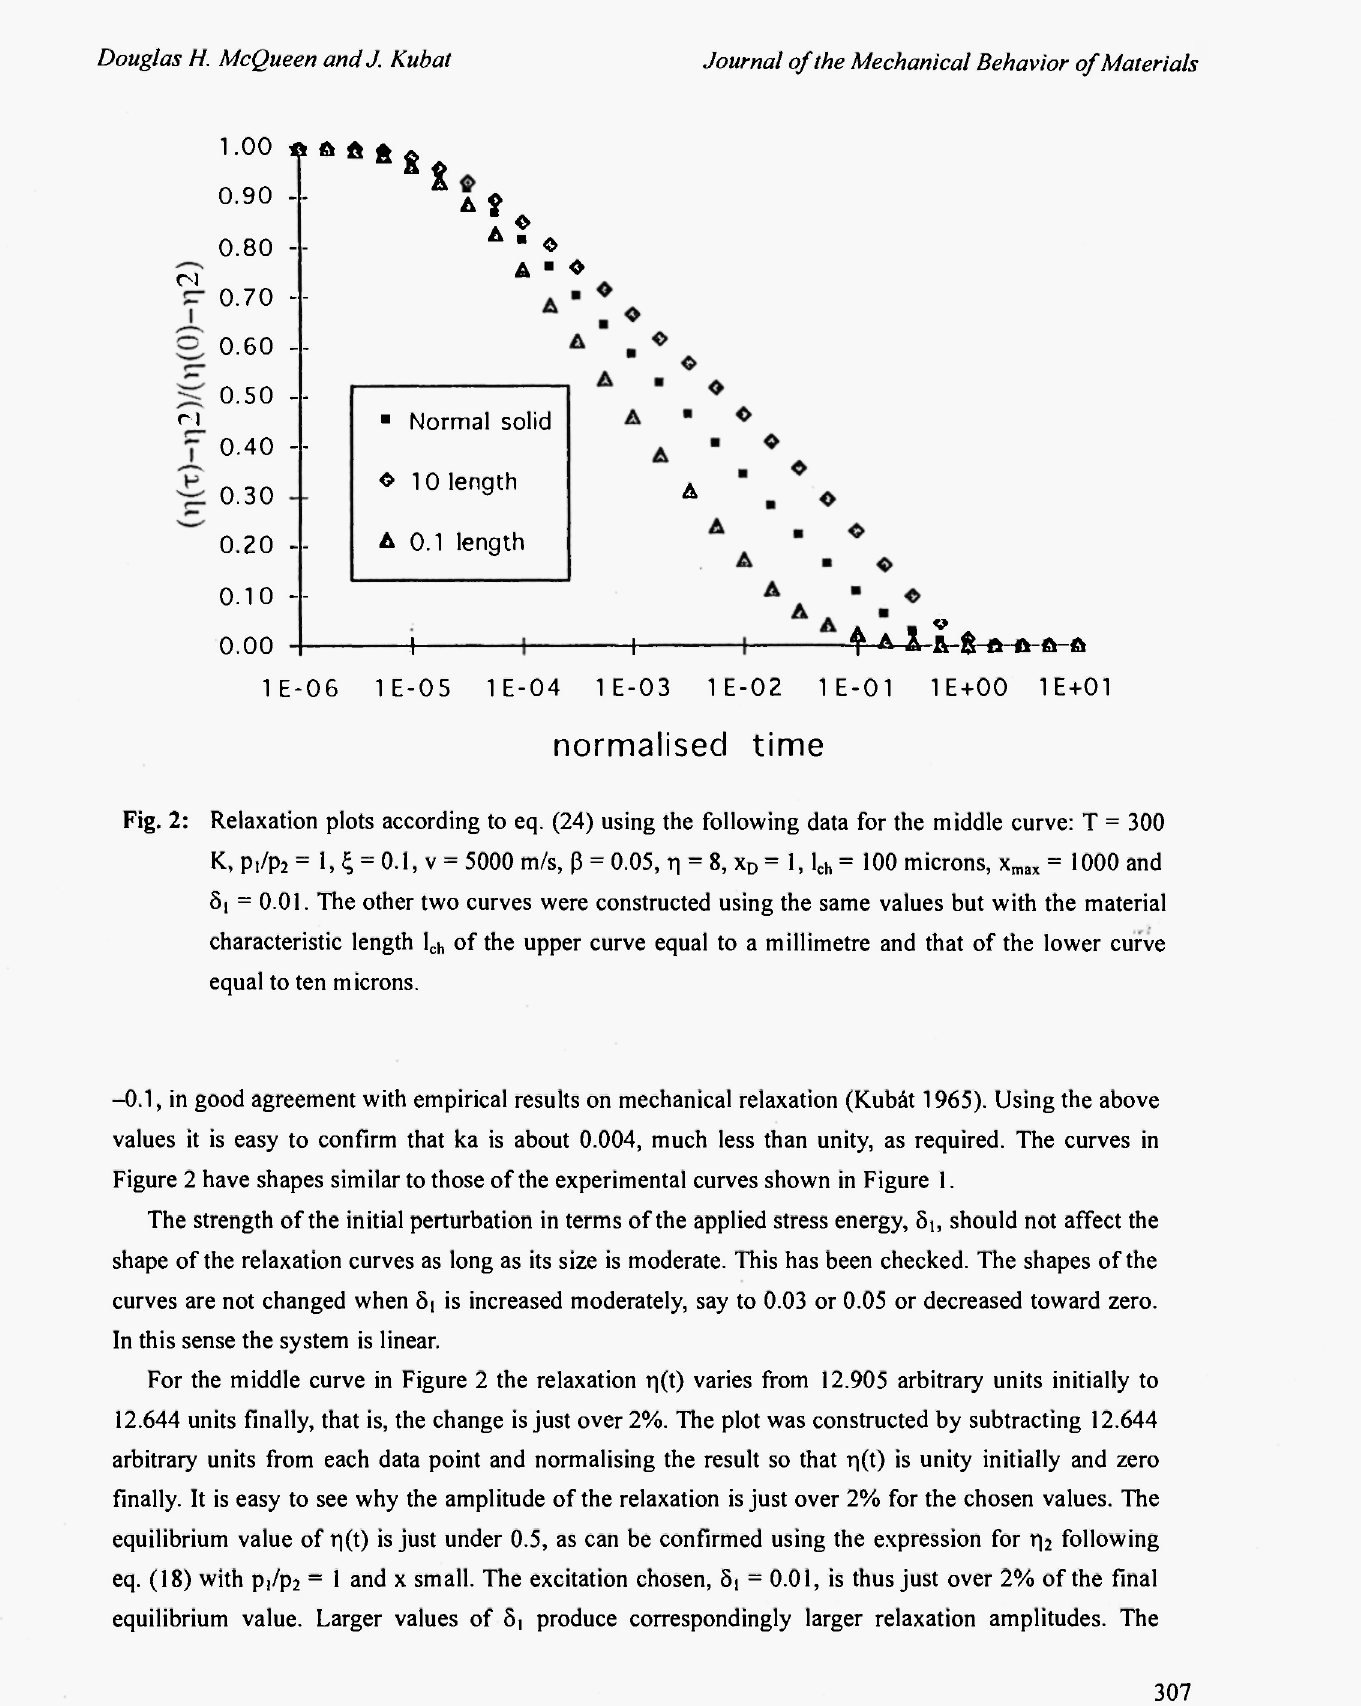
Relaxation plots according to eq. (24) using the following data for the middle curve: Τ = 300 Κ, p,/p 2 = 1, ξ = 0.1, ν = 5000 m/s, β = 0.05, η = 8, x D = 1, l ch = 100 microns, x max = 1000 and δι =0.01. The other two curves were constructed using the same values but with the material characteristic length l ch of the upper curve equal to a millimetre and that of the lower curve equal to ten